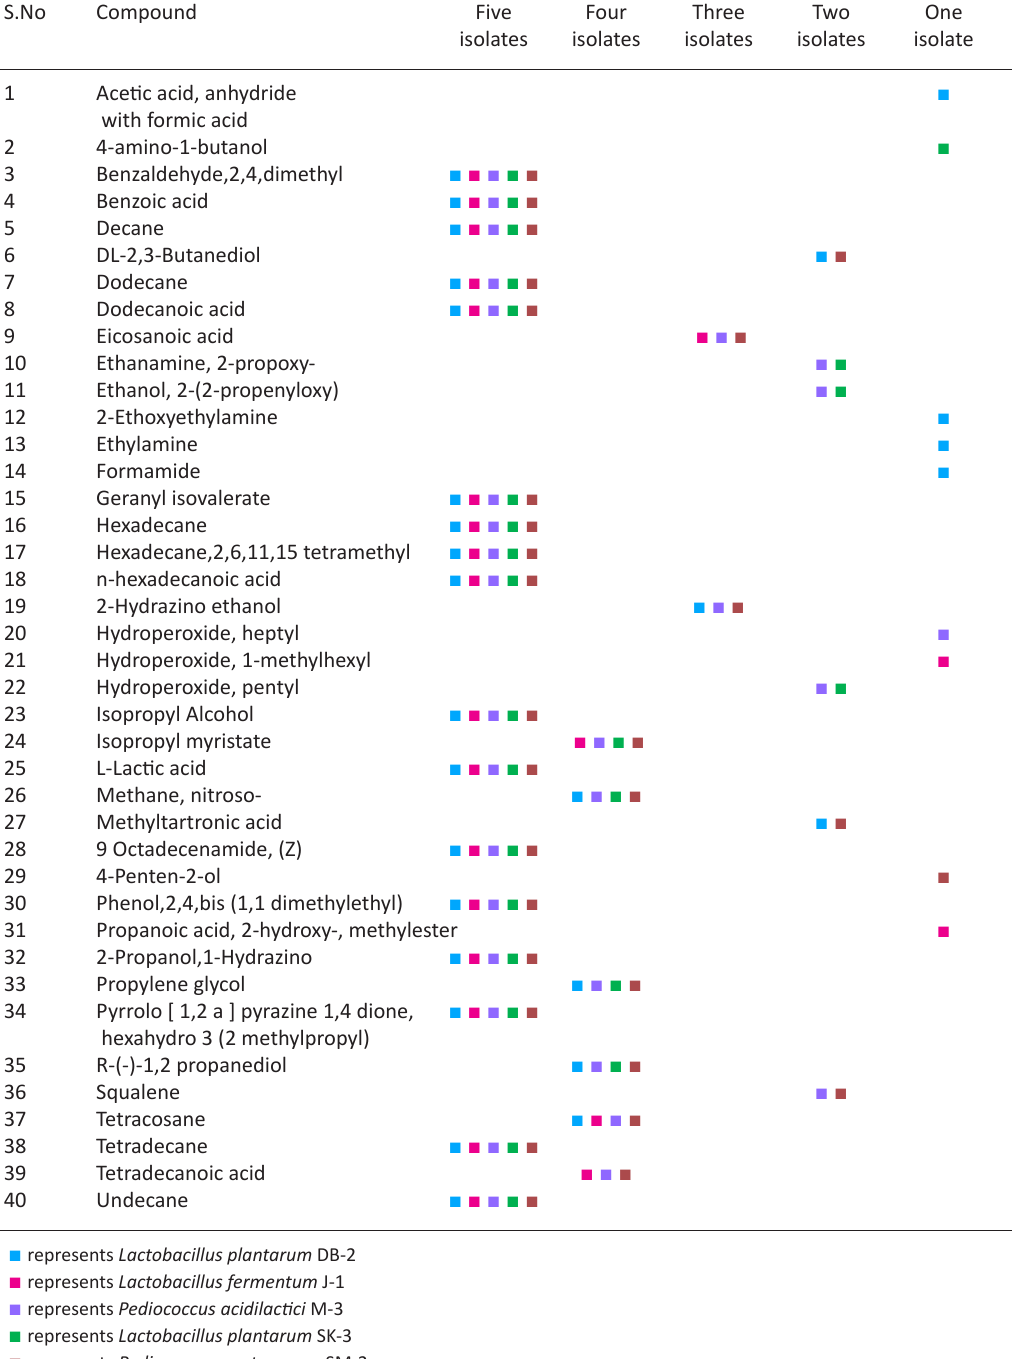
Table 2. Metabolic profile of biocomponents identified in solvent extract of probiotic lactic acid bacteria isolated by GC-MS S.No Compound Five Four Three Two One isolates isolates isolates isolates isolate